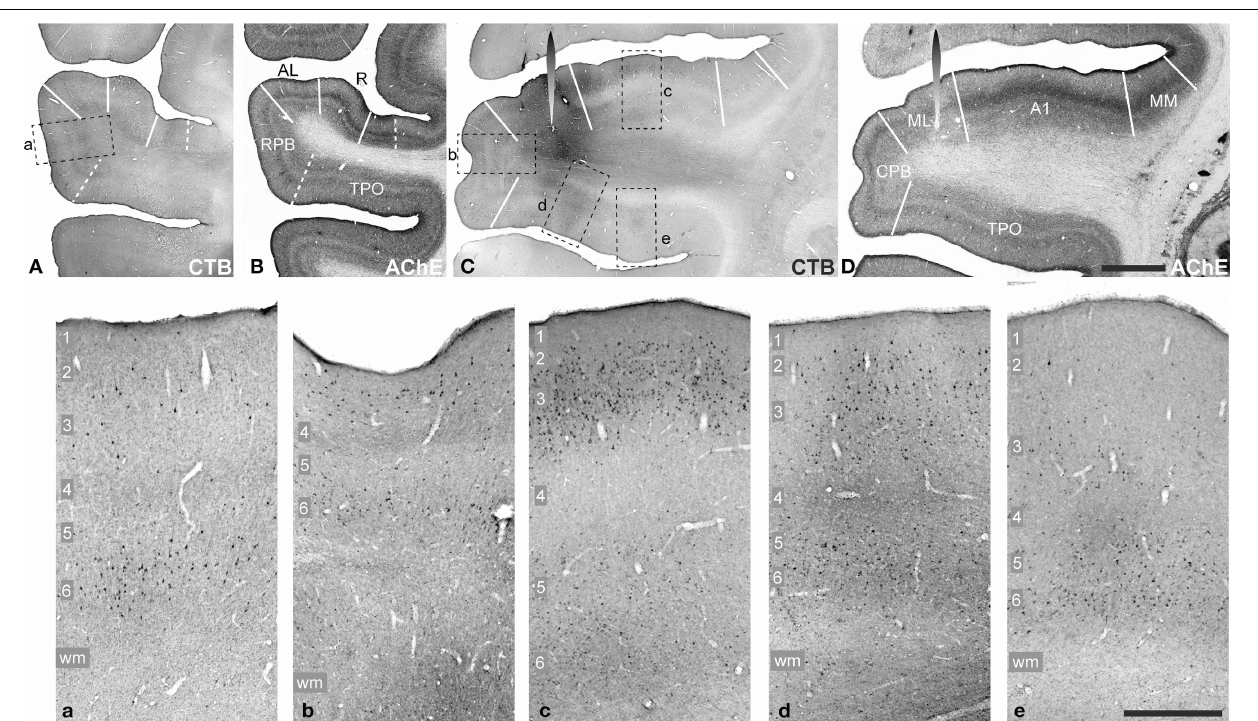
FIGURE 2 | CTB labeling (A,C, a–e) and AChE histochemistry (B,D) in Case 1. CTB injection into area ML visible in (C,D) (spearhead symbol). Adjacent sections processed for CTB and AChE at a more rostral location at the level of the RPB (A,B) . Rectangles in (A,C) denote locations of panels